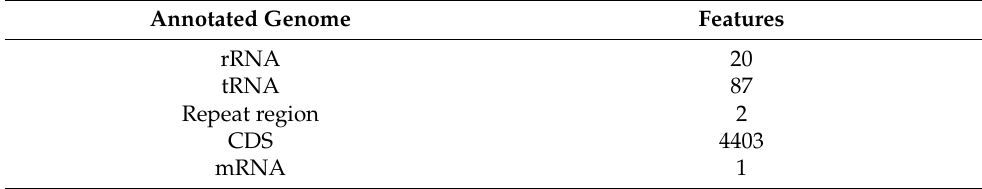
Table 4. Salmonella SE3 genome features annotated by